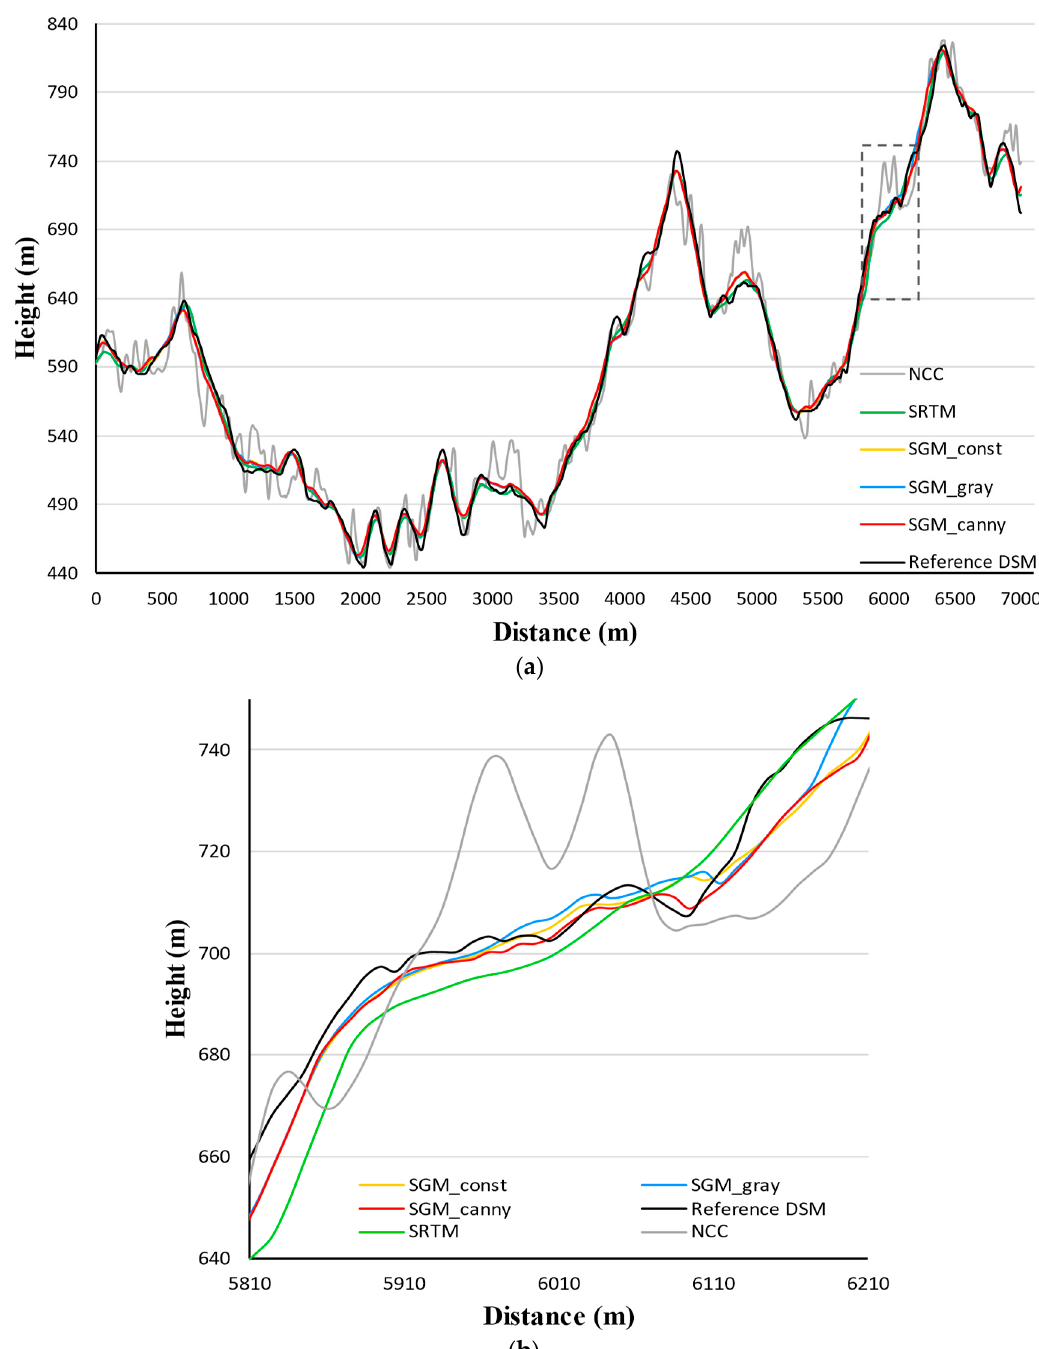
Figure 6. ( a ) DSM profiles along the line segment “m” in Figure 5c; ( b ) Zoomed view of the profiles corresponding to the dotted box in Figure 6a.